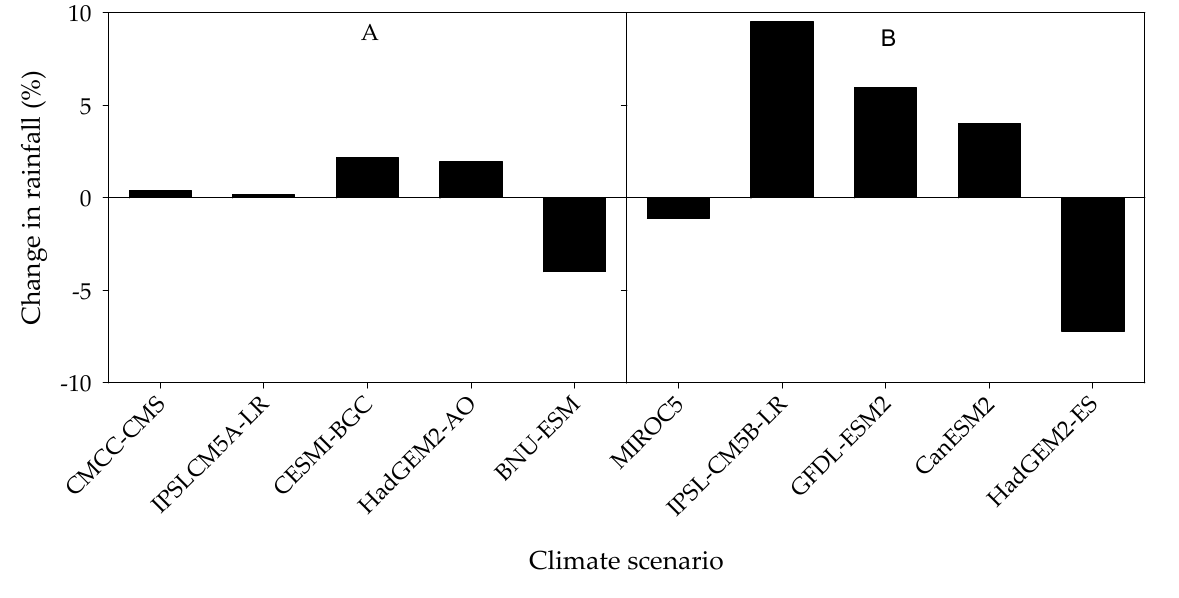
Figure 7. Projected changes in rainfall amount for 5 general circulation models under two representative concentration pathways (RCP 4.5 and 8.5; A and B respectively) and for the period 2040–2069. Rainfall was counted as an event if a minimum value of 2.5 mm rainfall was observed.